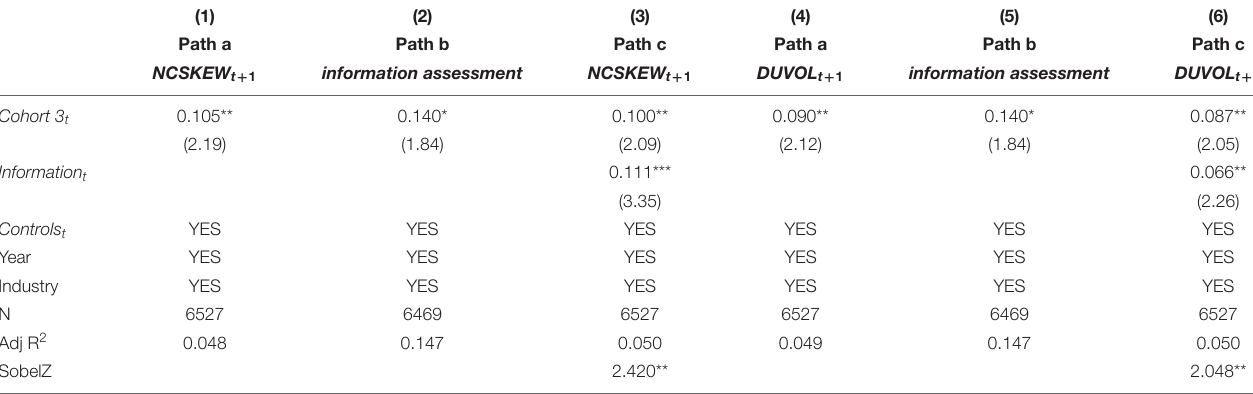
TABLE 14 | Robustness check: Channel